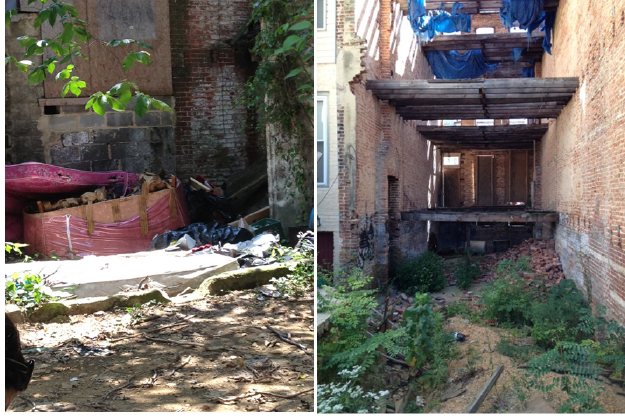
Figure 1. Degraded infrastructure in Baltimore, MD. Source: S.